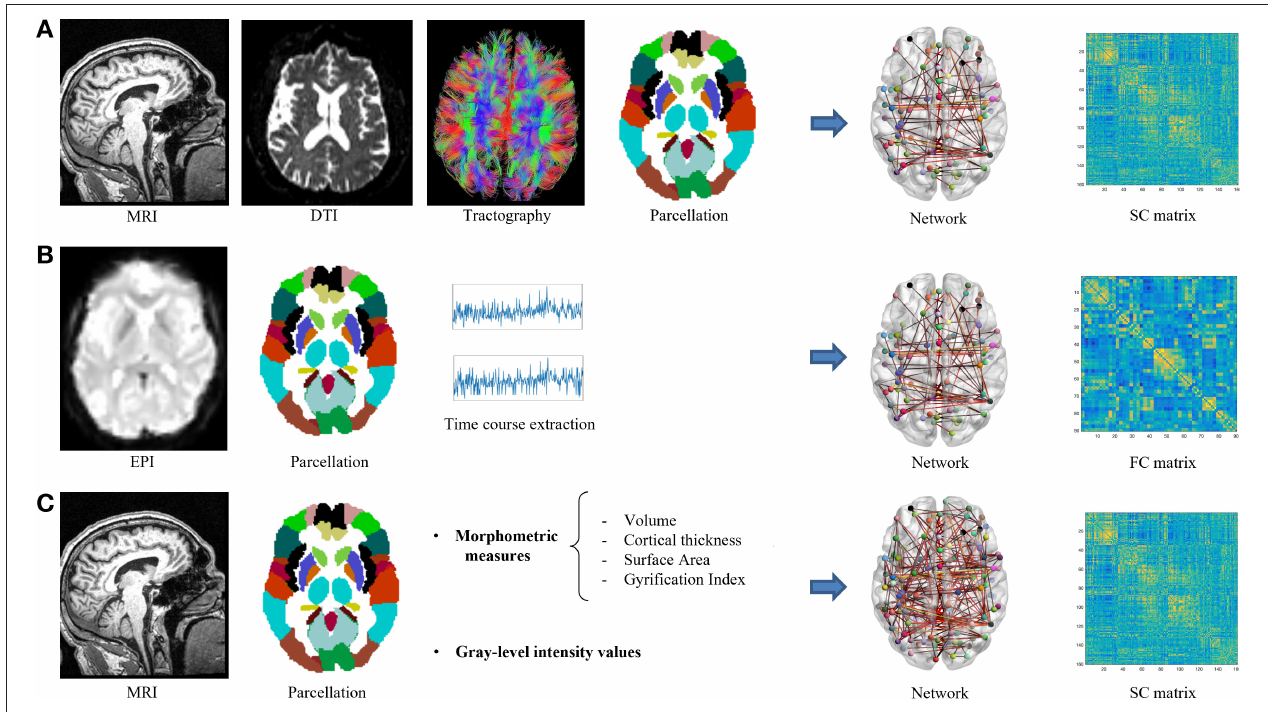
FIGURE 1 | Schematic representation of brain network construction. (A) Diffusion tensor imaging; (B) resting-state fMRI; (C) gray matter structural